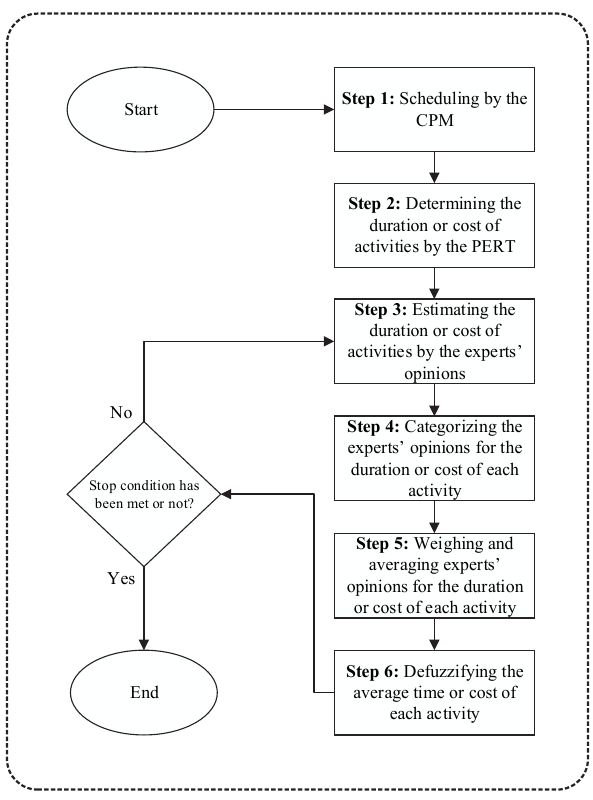
Fig. 1. Flowchart of the proposed